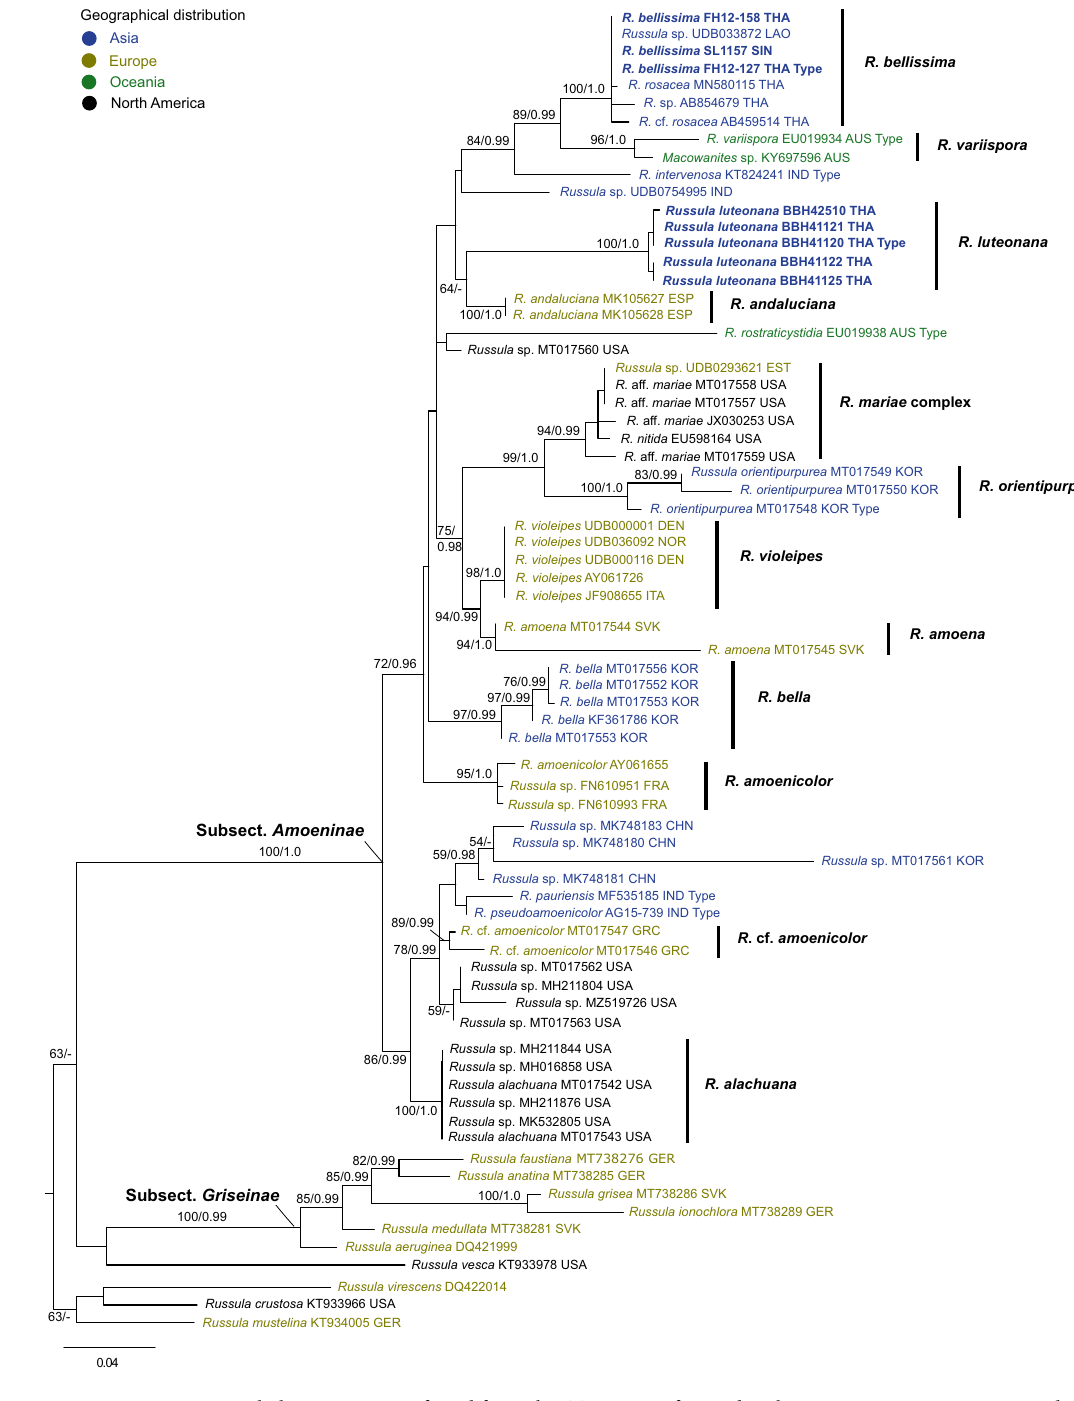
Figure 2. ML phylogenetic tree inferred from the ITS region of Russula subsection Amoeninae species and allied groups, using ML and BI methods. Samples in boldface are new species in this study. Bootstrap support values (BS ≥ 50%) and posterior probabilities (PP ≥ 0.90) are shown at the supported